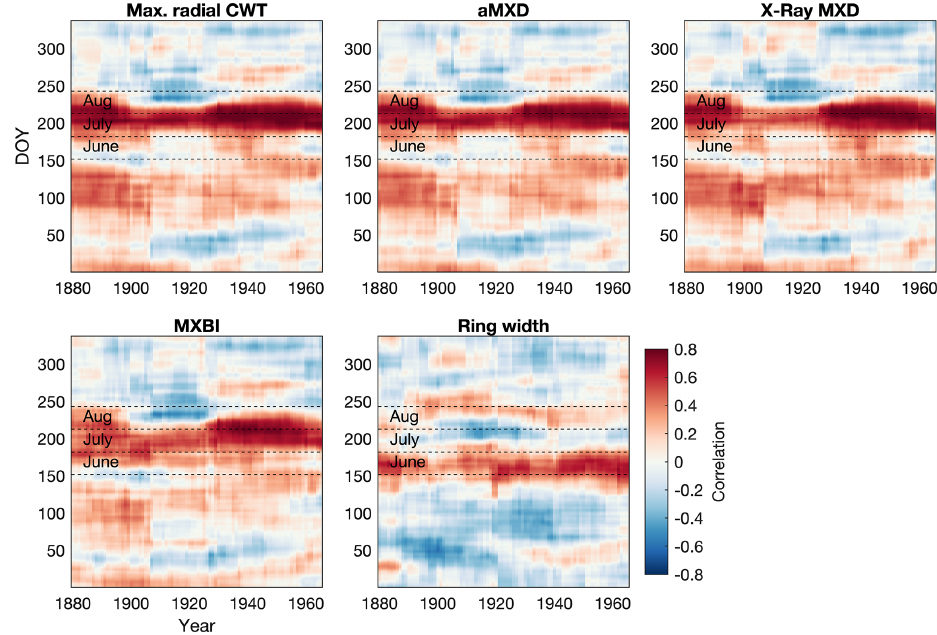
Figure 5. Moving correlation between the full tree ring parameter datasets and Berkeley Earth gridded daily temperatures (grid 52.5 ◦ N 118.5 ◦ W, 1880–1994 period). A 30-year moving window, shifted by 1 year, was used in the analysis. Temperatures were averaged over a 30d window and shifted throughout the year at daily steps. The days on the x and y axes thus show the first day of the 30-year and 30d windows, respectively, e.g., day 152 on the y axis represents the period 1–30 June. Both tree ring and temperature data have been detrended prior to analysis. The months June–August are highlighted to aid interpretation. Pearson’s correlations between monthly aggregated (i.e., average daily data for each calendar month) Berkeley Earth temperatures and tree ring parameters are provided in Fig. S6 for